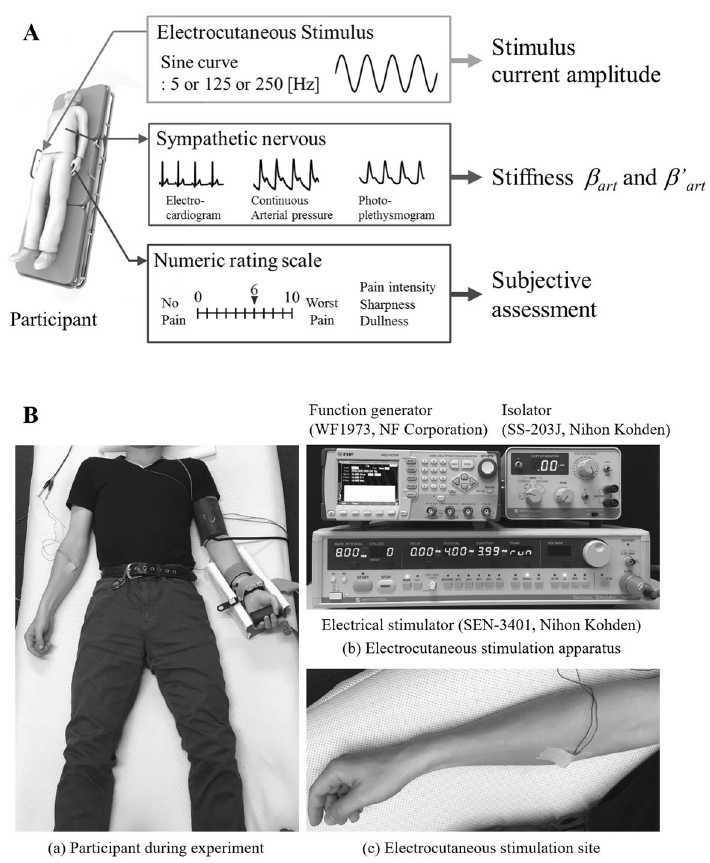
Figure 2. Experimental environment. ( A ) Measurements of biosignals and the stimuli applied. Sinusoidal electrocutaneous stimuli with different amplitudes and frequency conditions were applied to evoke different pain intensities. Peripheral arterial stiffness was calculated from electrocardiograms, continuous arterial pressures, and photo-plethysmography. Subjective assessments of pain intensity were obtained verbally. ( B ) (a) Shows a participant with sensors attached to measure electrocardiograms, continuous arterial pressure, and photo-plethysmography, and (b) shows the pain stimulation apparatus, which consisted of a function generator, an isolator, and an electrocutaneous